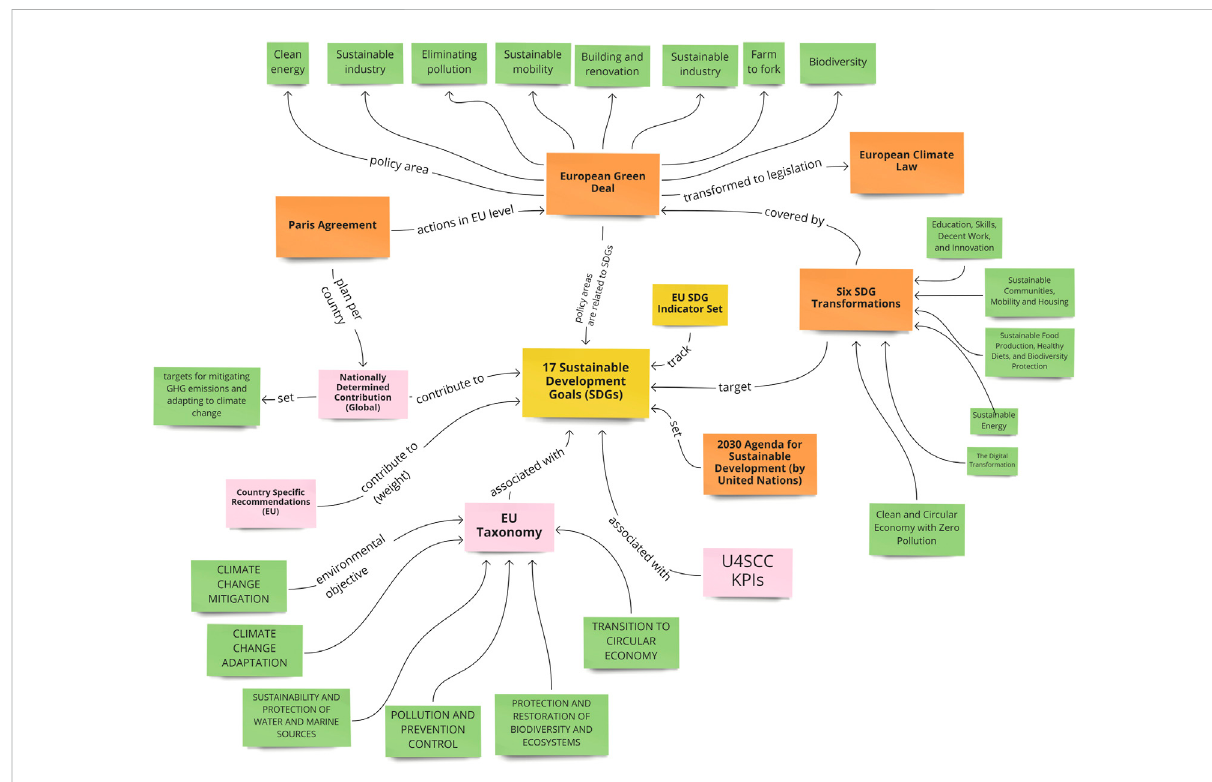
FIGURE 1 High level view of climate change related policies and